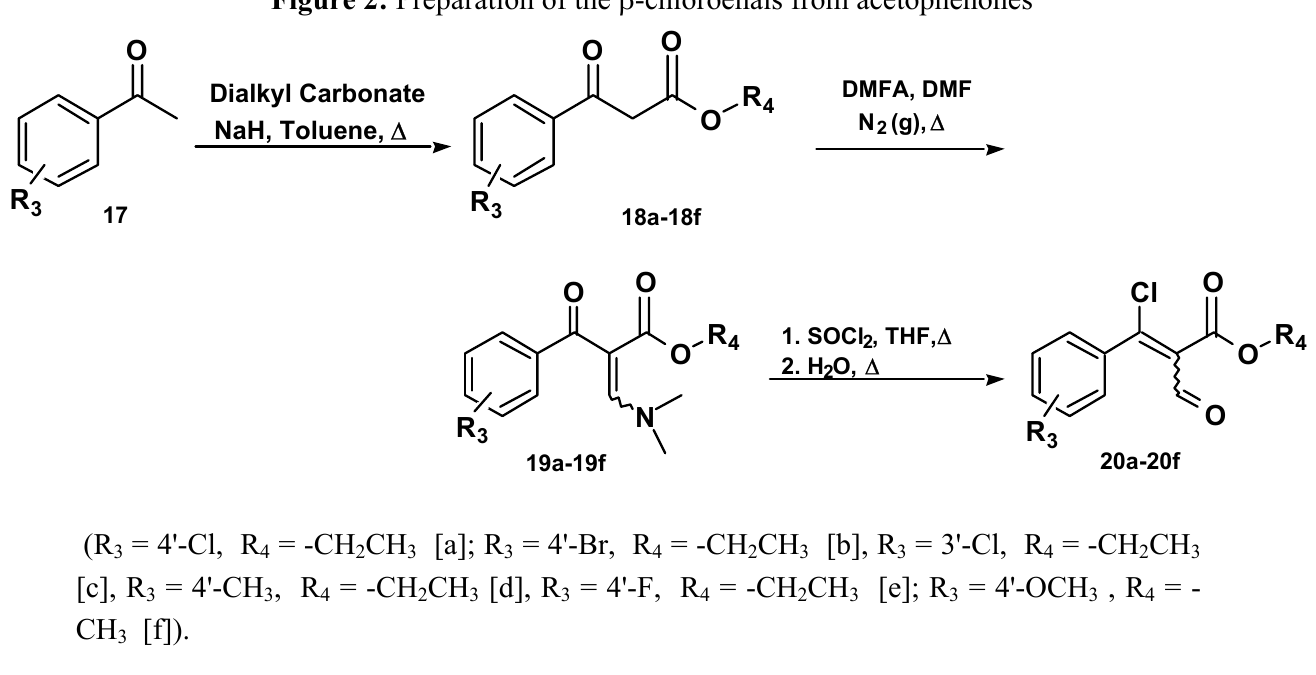
Figure 3: Preparation of the salt of the α -aminoketones from 2-bromoacetophenones